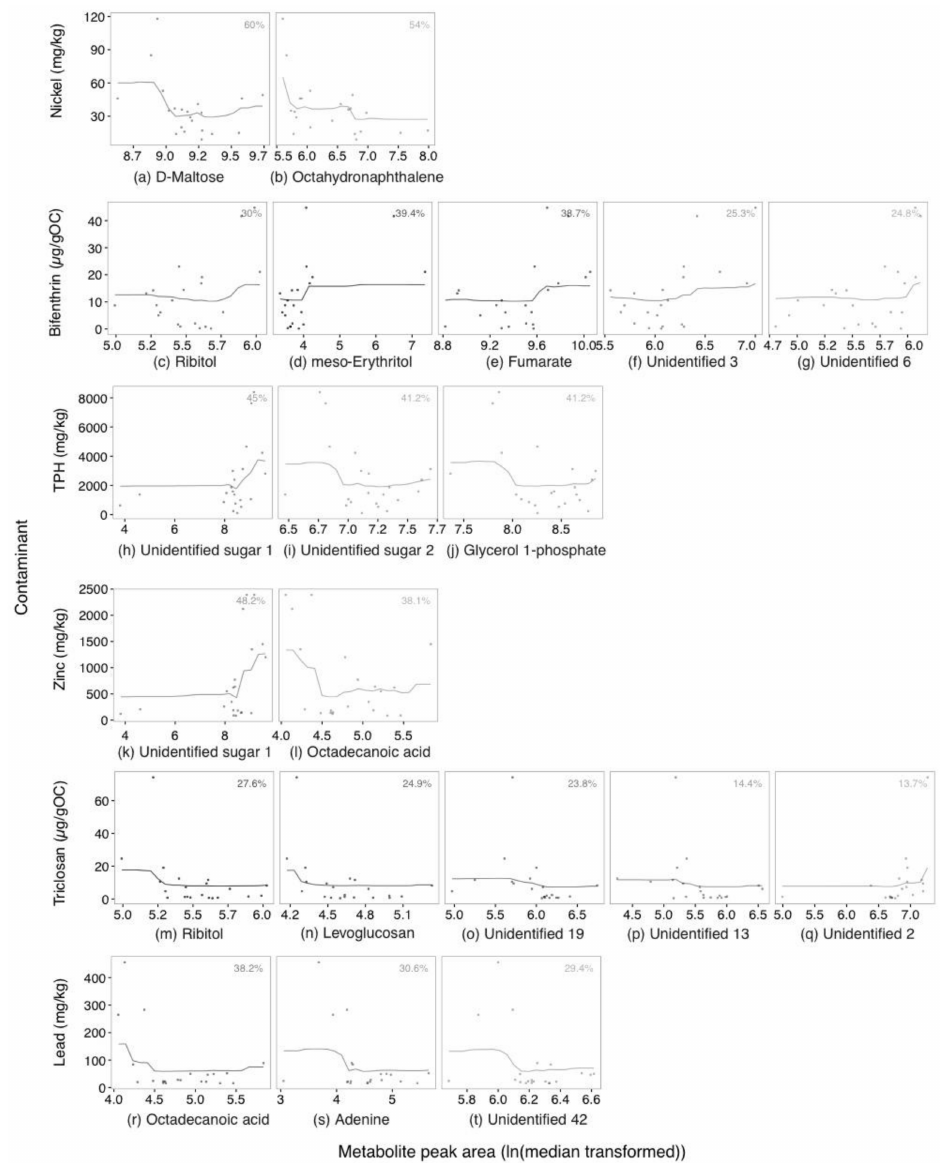
Figure 3. Results of random forest modelling, with partial dependence plots showing the association of Procladius villosimanus GC-MS annotated metabolites with nickel ( a , b ), bifenthrin ( c – g ), total petroleum hydrocarbons (TPH) ( h – j ), zinc ( k , l ), triclosan ( m – q ) and lead ( r – t ). Percent increase in mean squared error (%IncMSE) for each metabolite is indicated in the top corner of each panel and visualized with